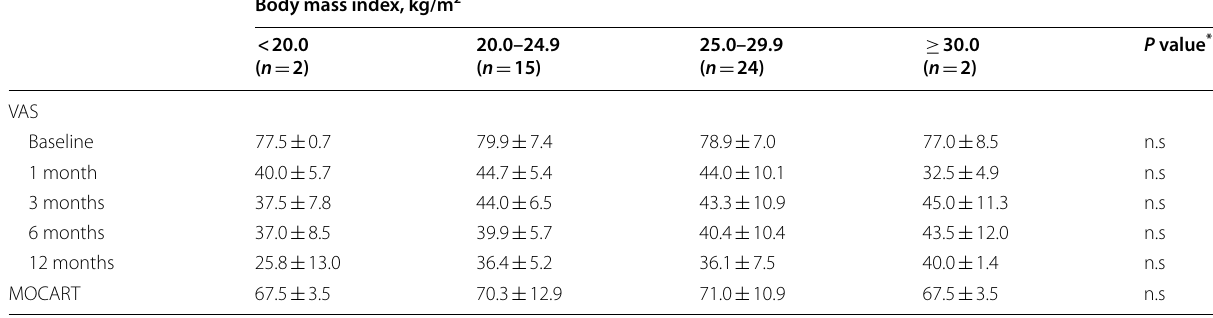
Data are presented as means standard deviation ± MOCART Magnetic resonance observation of cartilage repair tissue, VAS Visual analogue scale * Kruskal–Wallis test